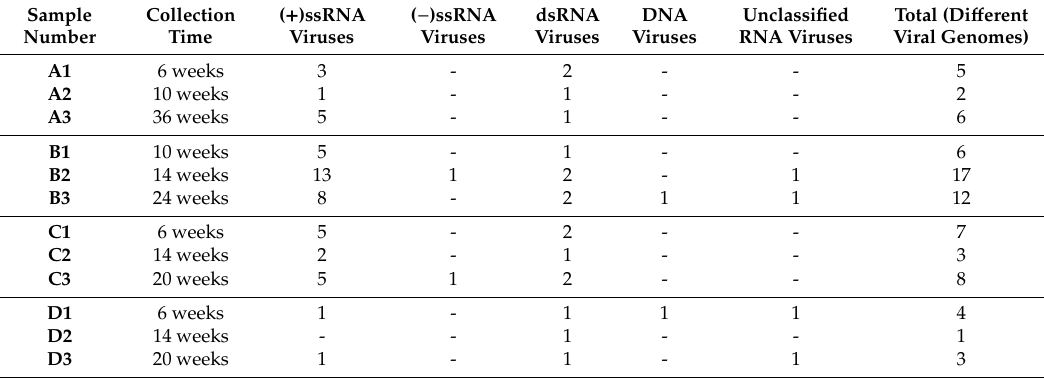
Table 3. Di ff erent types of viruses detected from twelve faecal samples categorized based on the genome type.